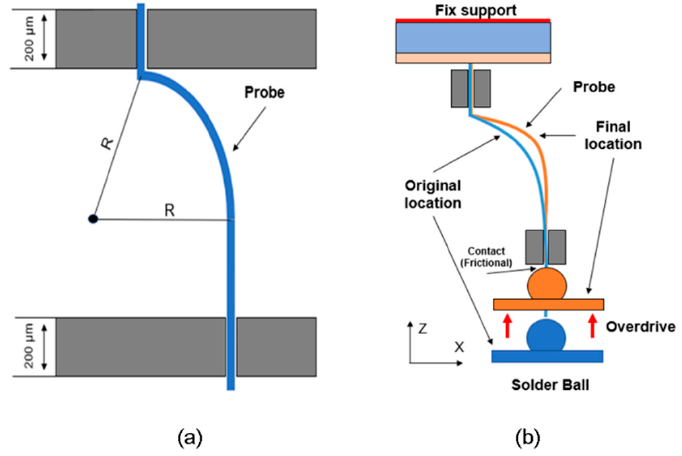
Figure 1. ( a ) Geometric model of the MEMS vertical probe. ( b ) Schematic drawing of the behavior of the vertical probe in contact with a solder ball.